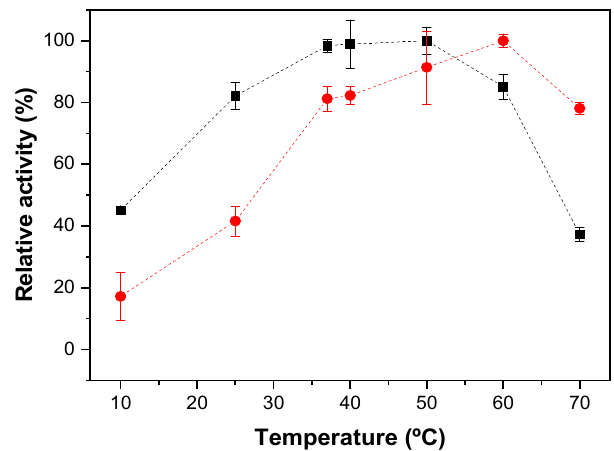
Figure 4. Effect of the temperature on the activities of ( ) liquid Eversa and ( ) Eversa-mCLEA. The activity was determined by tributyrin hydrolysis (soluble enzyme concentration of 5 mg/mL or 10 mg of Eversa-mCLEA, pH 7.0, 100 mM sodium phosphate buffer).